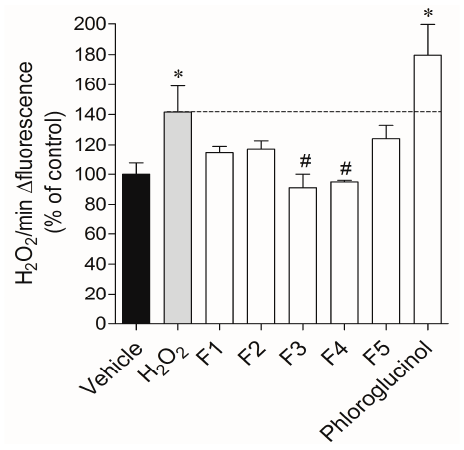
Figure 3. Real-time H 2 O 2 quantification on MCF-7 cells in the absence or presence of Fucus spiralis fractions (1 mg/mL; 24 h). Each column represents the mean ± standard error of the mean (SEM) of three or four independent experiments. Symbols represent statistically significant differences ( p < 0.05, ANOVA, Dunett’s test) when compared to: * vehicle and # to H 2 O 2 .